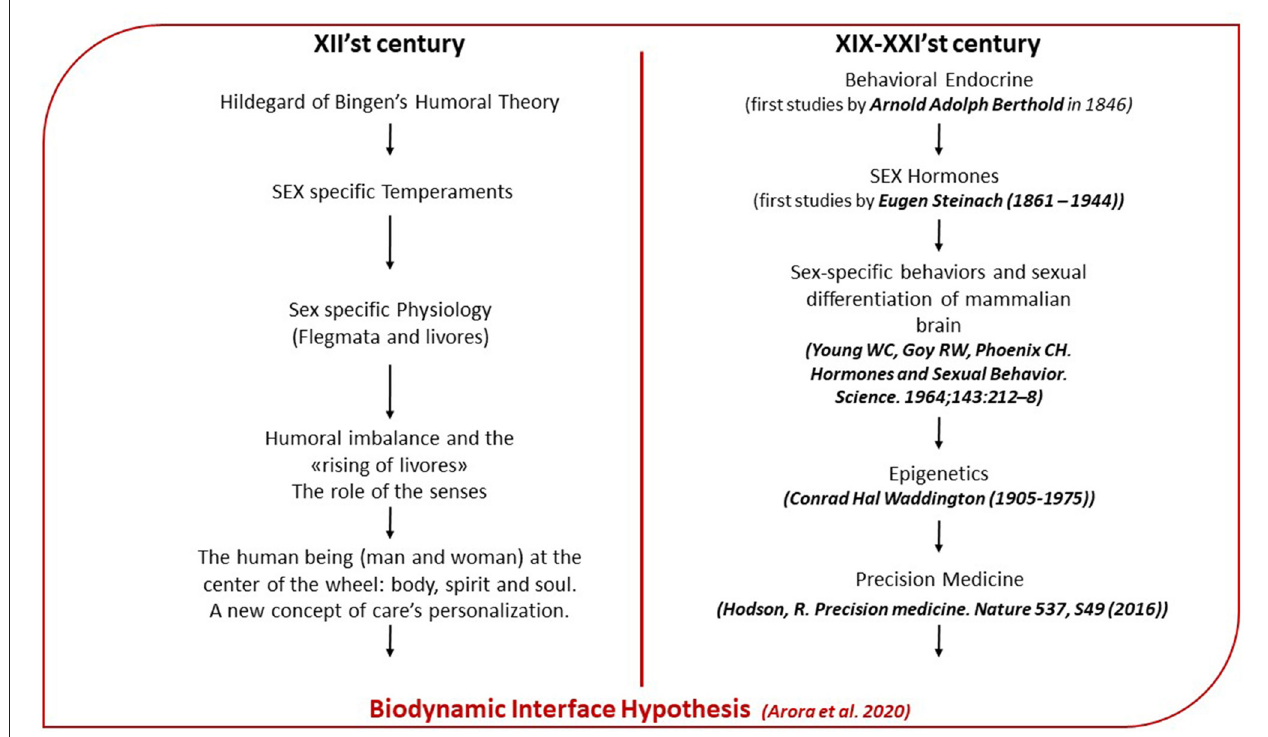
FIGURE 2 | Parallelism between Hildegardian medicine and modern medicine: on the left of the flow chart are summarized main aspects of the Hildegardian medicine. On the right are the reported fields of the modern medicine wherein Hildegardian medicine finds a modern interpretation.